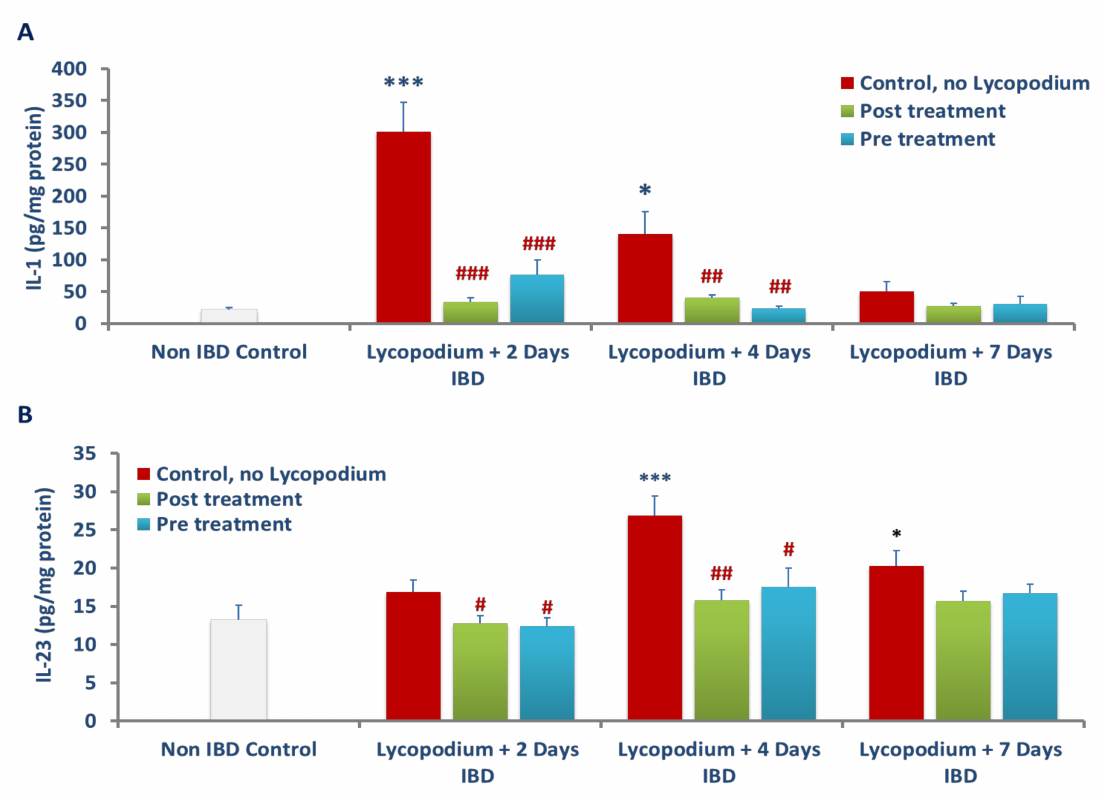
Figure 7. Effect of lycopodium on proinflammatory cytokines; IL-1 β ( A ), and IL-23 ( B ) in acetic acid-induced IBD in rats. Results are mean ± SEM. * p < 0.05, *** p < 0.001 vs. non IBD control group; # p < 0.05, ## p < 0.01, ### p < 0.001 vs. relative IBD control